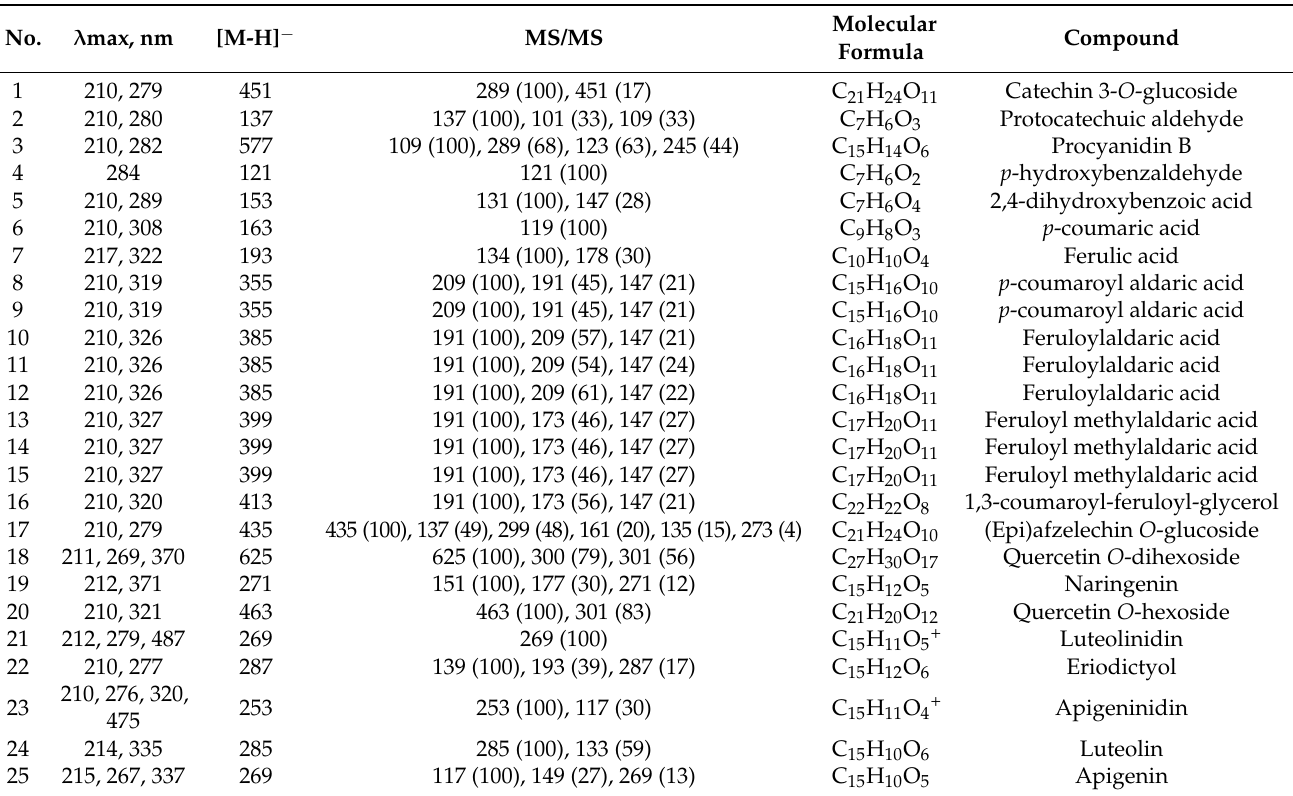
Key: No. = arbitrary number for counting compounds identified; λ max = UV wavelength at maximum absorption; [M-H] − = precursor ions; MS/MS = product ions. Hydroxybenzoic acids were identified at 280 nm; hydroxycinnamic acids, their derivatives, and flavonoids at 350 nm; and 3-deoxyanthocyanidins were identified at 450